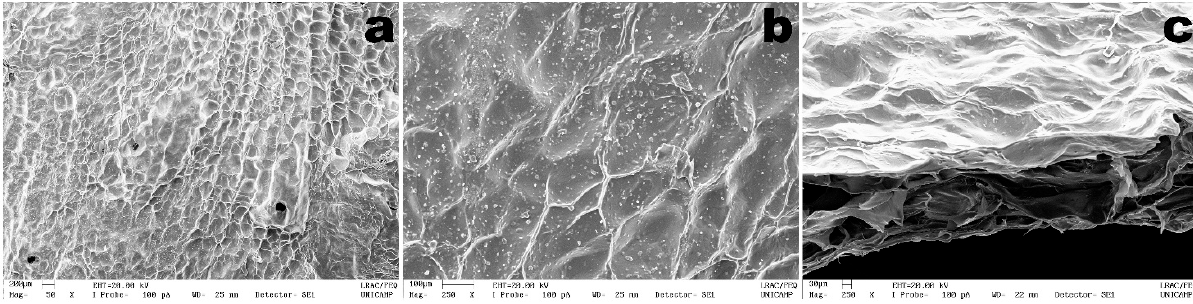
Figure 5. DESEM (dispersive-energy scanning electron microscopy) photomicrographs of the bioluminescent/chromogenic hydrogel surface (( a ) ×50, ( b ) ×250, and of the cross-section fracture zone (( c ) ×250).